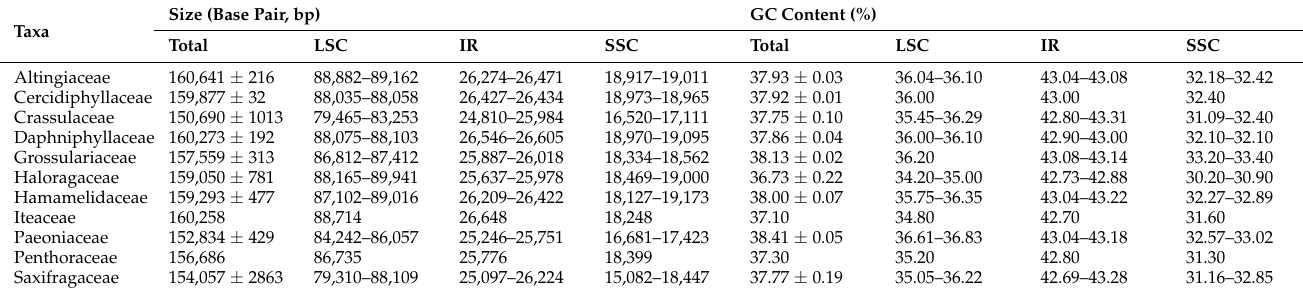
Table 1. Basic genomic characteristics among the investigated 208 Saxifragales